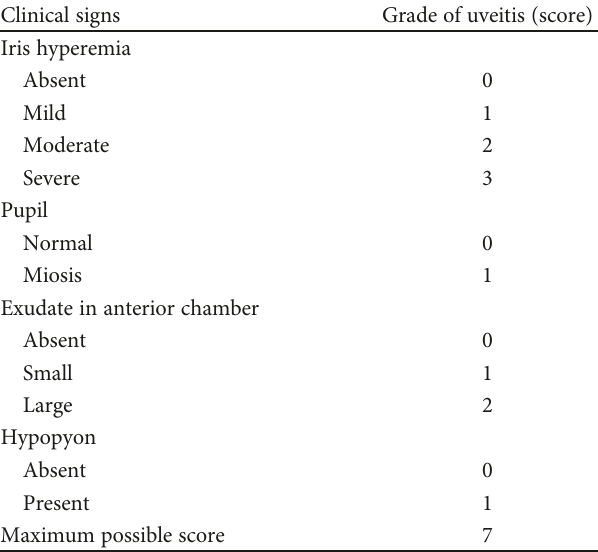
Table 1: Scoring system for clinical evaluation of